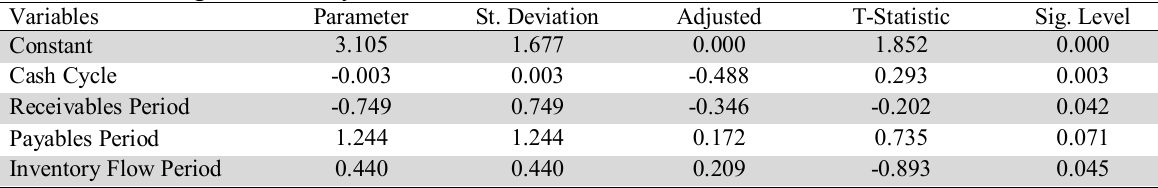
The results of regression analysis Variables